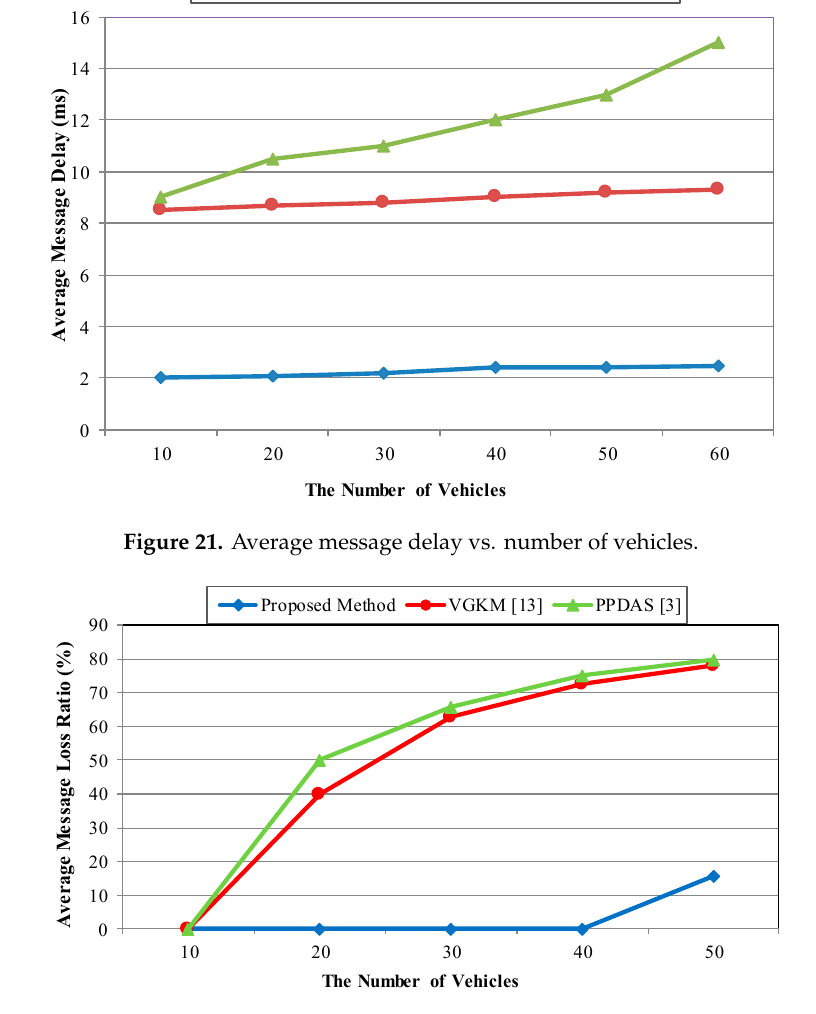
Figure 21. Average message delay vs. number of vehicles.